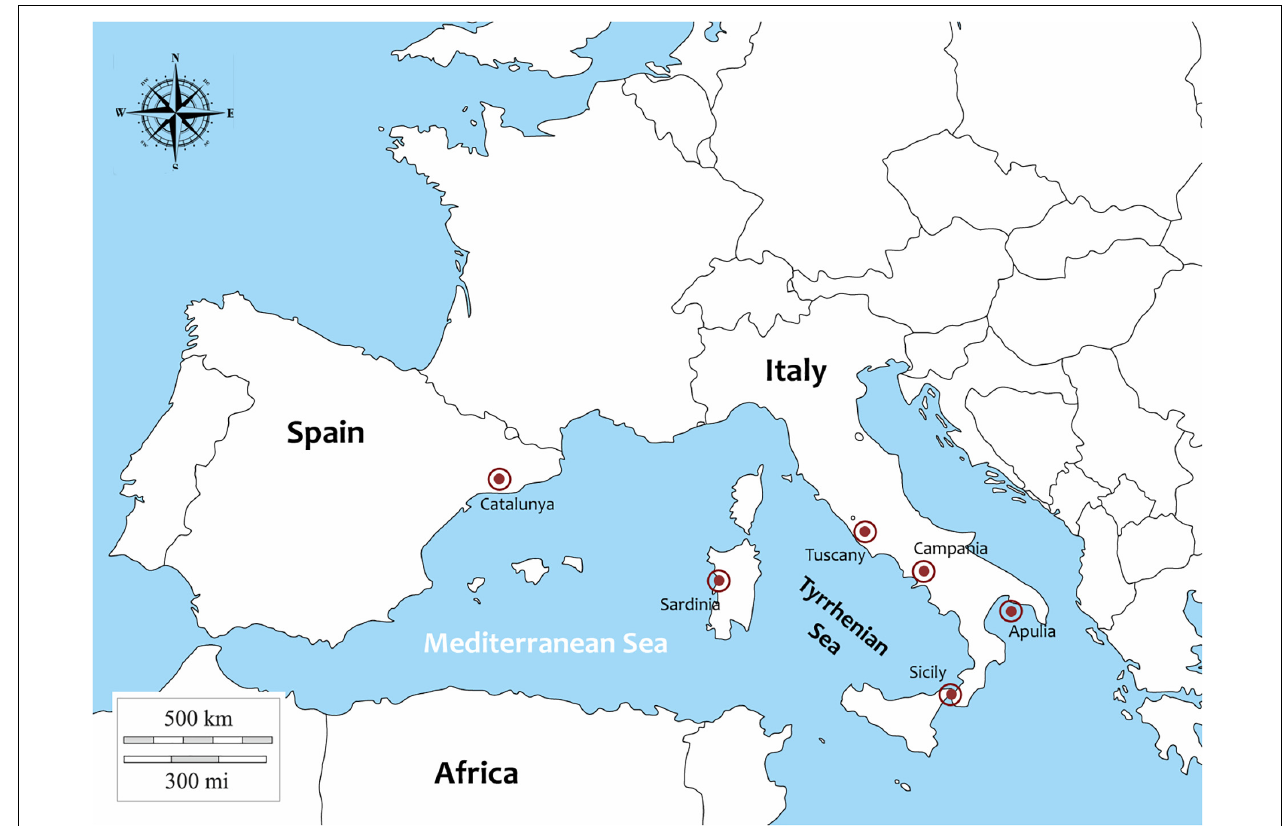
FIGURE 1 | Sampling areas of P. nobilis specimens in Italy and